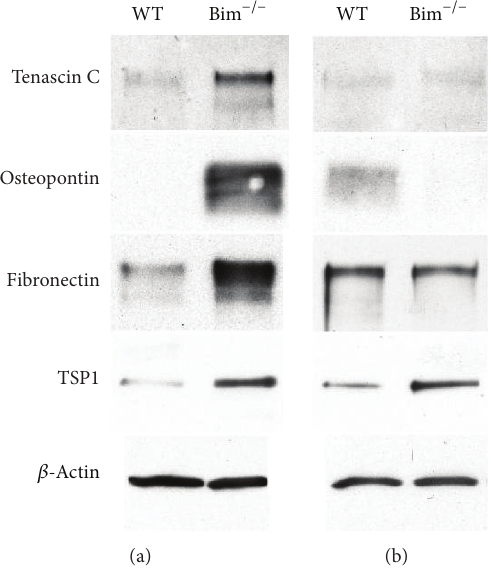
Figure 6: Altered expression of ECM proteins in Bim −/− retinal cells. Wild-type and Bim −/− retinal endothelial cells (panel (a)) and pericytes (panel (b)) were grown for 2days in serum-free medium. The medium was harvested, clarified, and Western-blotted for extracellular matrix proteins as noted. The expression of 𝛽 - actin from total cell lysates was used as a loading control. These experiments were repeated twice with similar